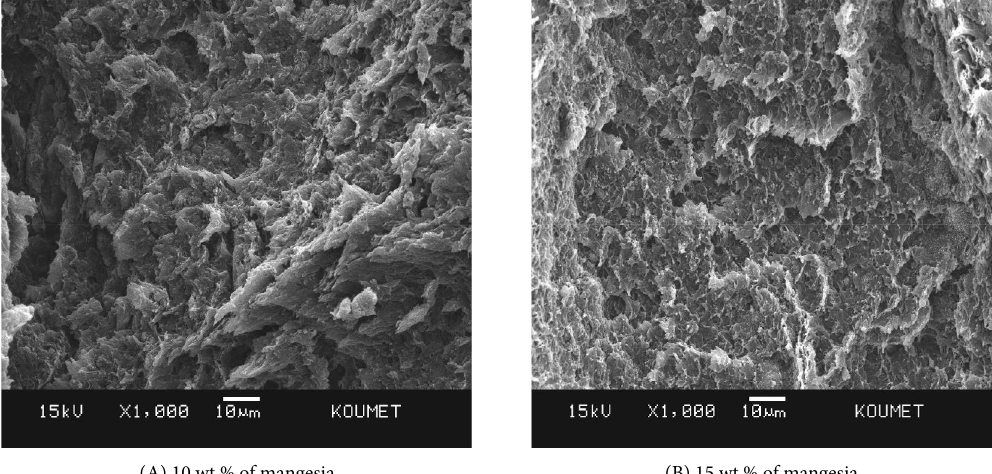
5000).(A) 10 wt.% of mangesia (B) 15 wt.% of mangesia